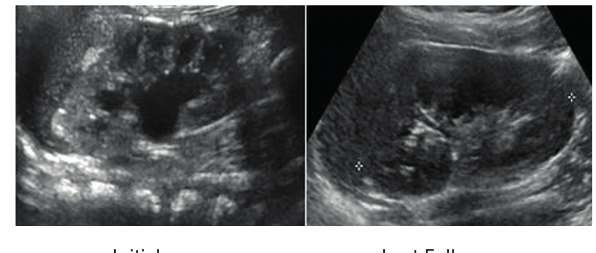
figure 2 - Renal US image in a patient with initial grade-2 HN and last follow-up US showing resolution of